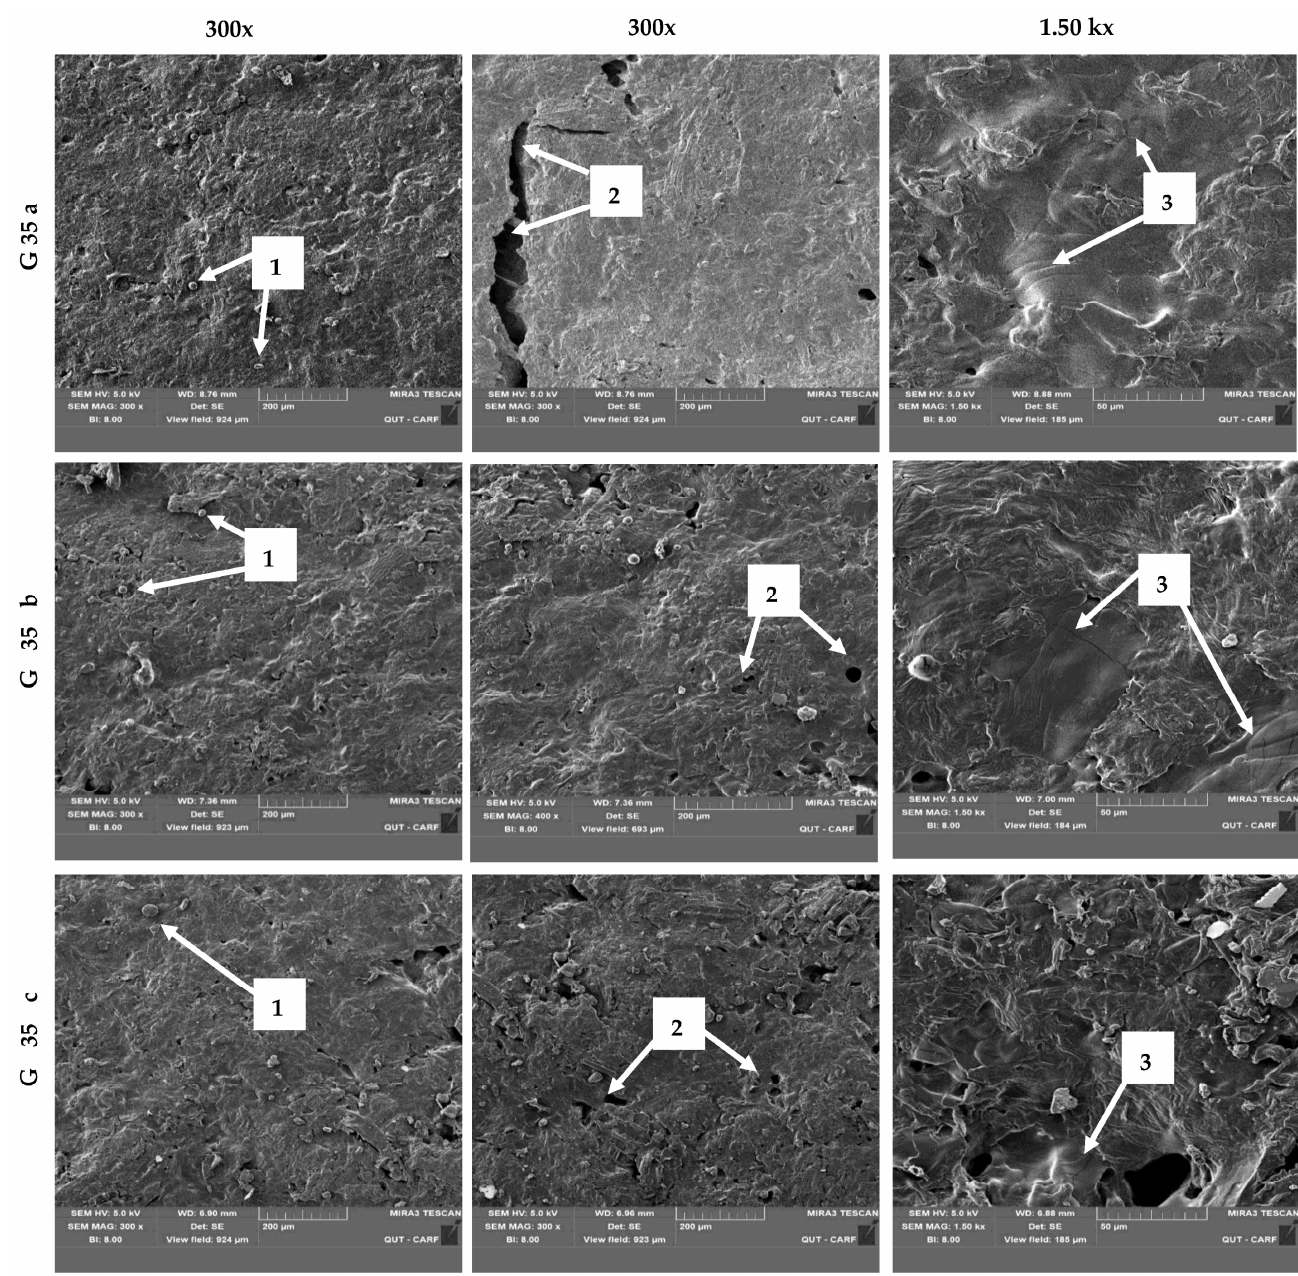
Figure 3. Scanning electron microscopic images of the hot-pressed films prepared with G 35 (35% glycerol) film-forming mixture under ( a ) 0.28 t ( b ) 0.42 t and ( c ) 0.84 t at 100 ° C temperature observed under 300 x and 1.5 kx magnification levels.